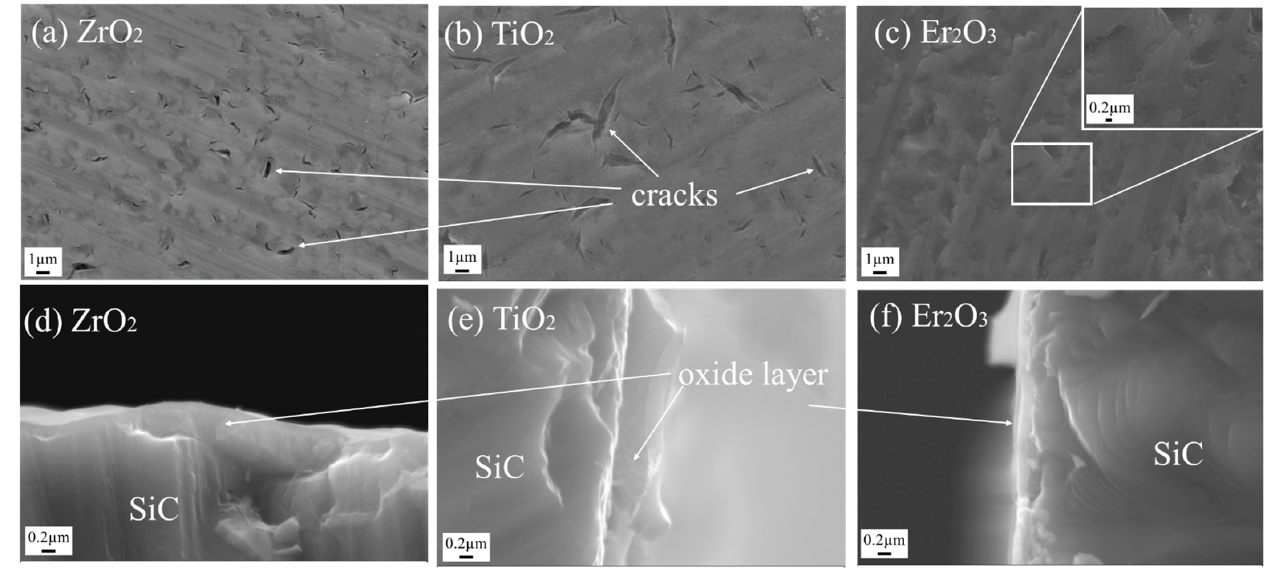
Figure 4. Surface and cross-sectional SEM images of oxides coating on CVD-SiC substrate after 1-time dipping before joining with SE2 mode. ( a , d ) are the images of surface and cross-section of 1-time dipped ZrO 2 coating, respectively; ( b , e ) are the images of surface and cross-section of 1-time dipped TiO 2 coating, respectively; ( c , f ) are the images of surface and cross-section of 1-time dipped Er 2 O 3 coating, respectively.